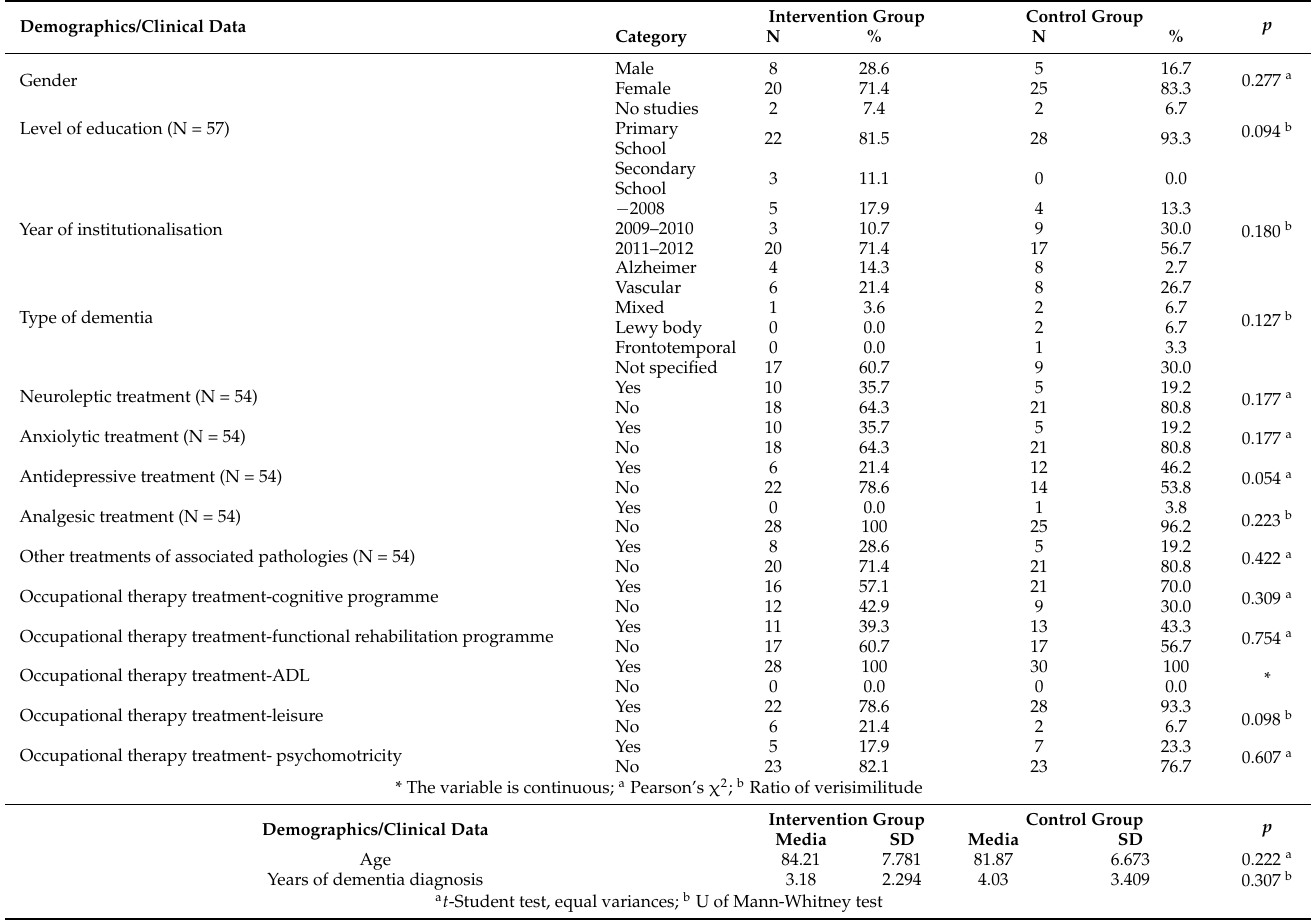
Table 1. Baseline socio-demographic data and homogeneity of the